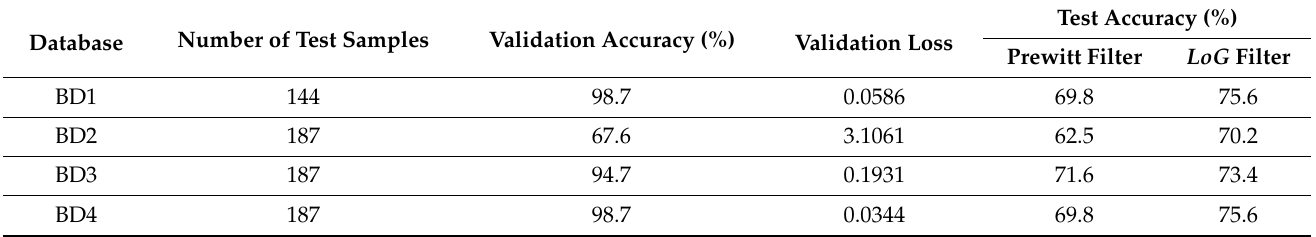
Table 4. The performance of the proposed